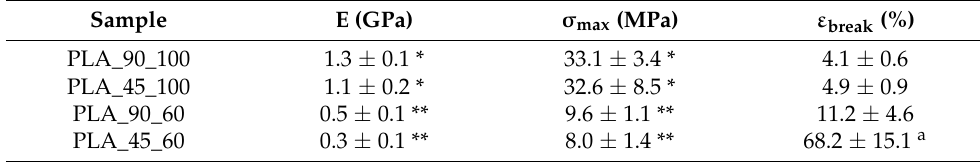
Table 6. Tensile mechanical parameters of PLA samples. Sample E (GPa) σ max (MPa) ε break (%) PLA_90_100 1.3 ± 0.1 * 33.1 ± 3.4 * PLA_45_100 PLA_90_60 PLA_45_60 0.3 ± 0.1 ** 8.0 ± 1.4 ** 68.2 ± 15.1